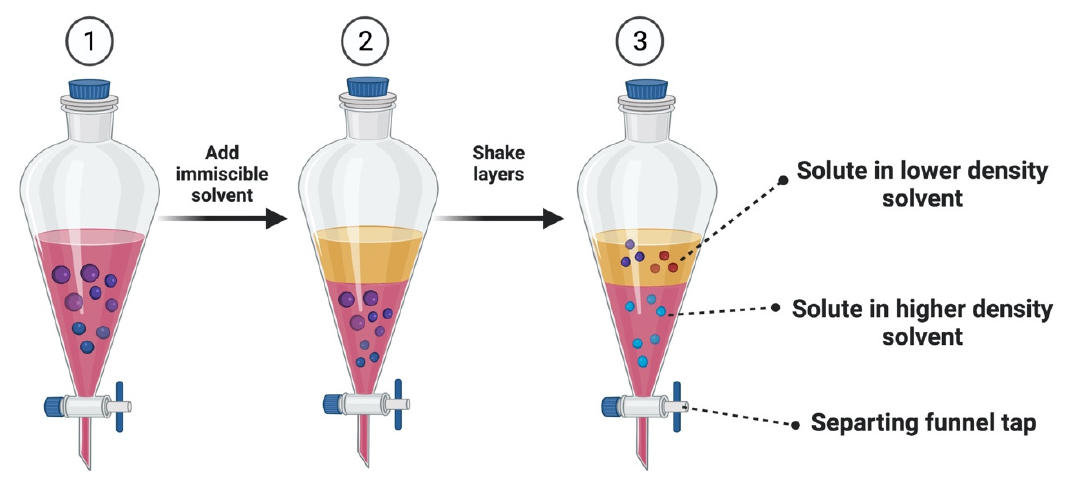
Figure 1. The processes in liquid–liquid